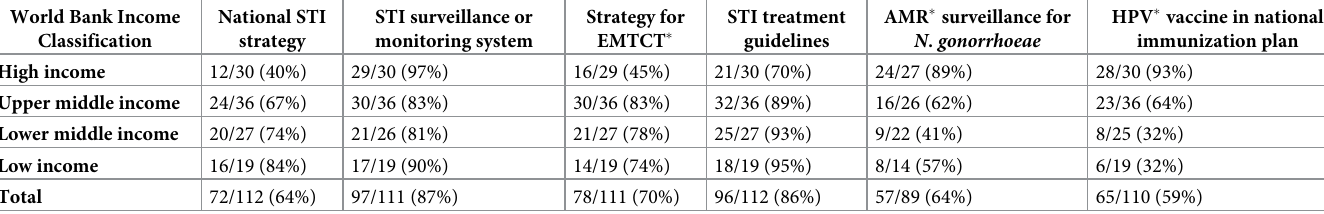
Table 2. National policies and guidelines for STI surveillance and programming by World Bank income classification.